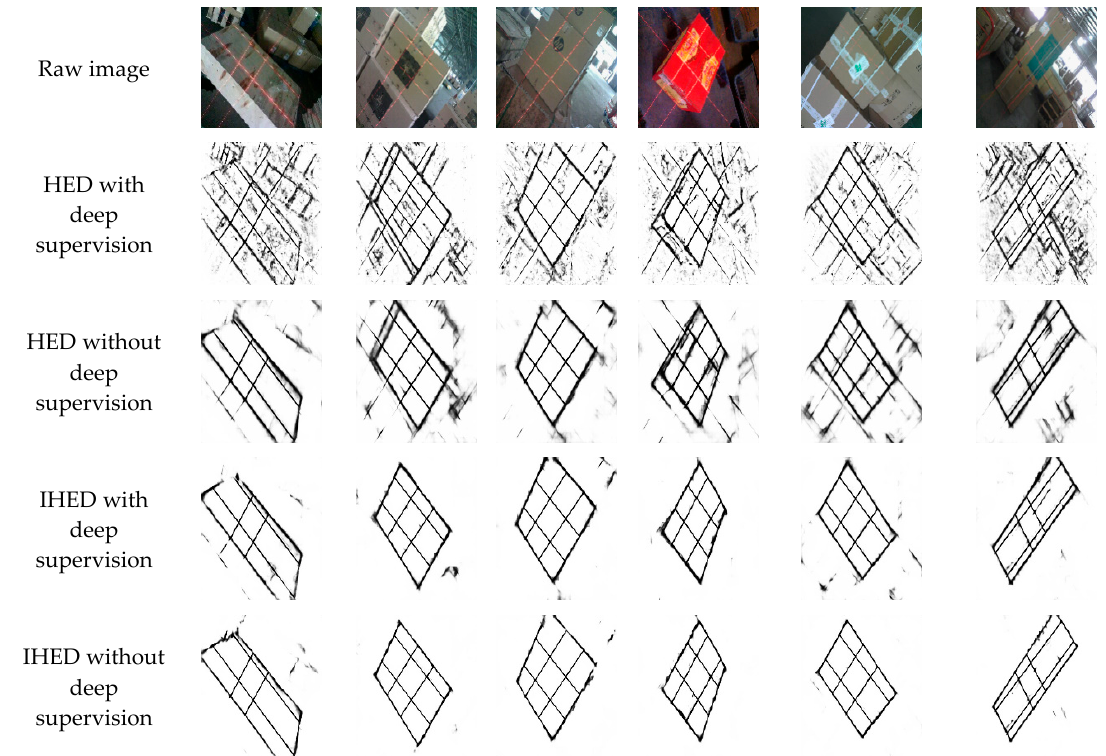
/ IHED network with / without deep supervision. Figure 12. Edge detection results by the HED/IHED network with/without deep supervision. Figure 12. Edge detection results by the HED